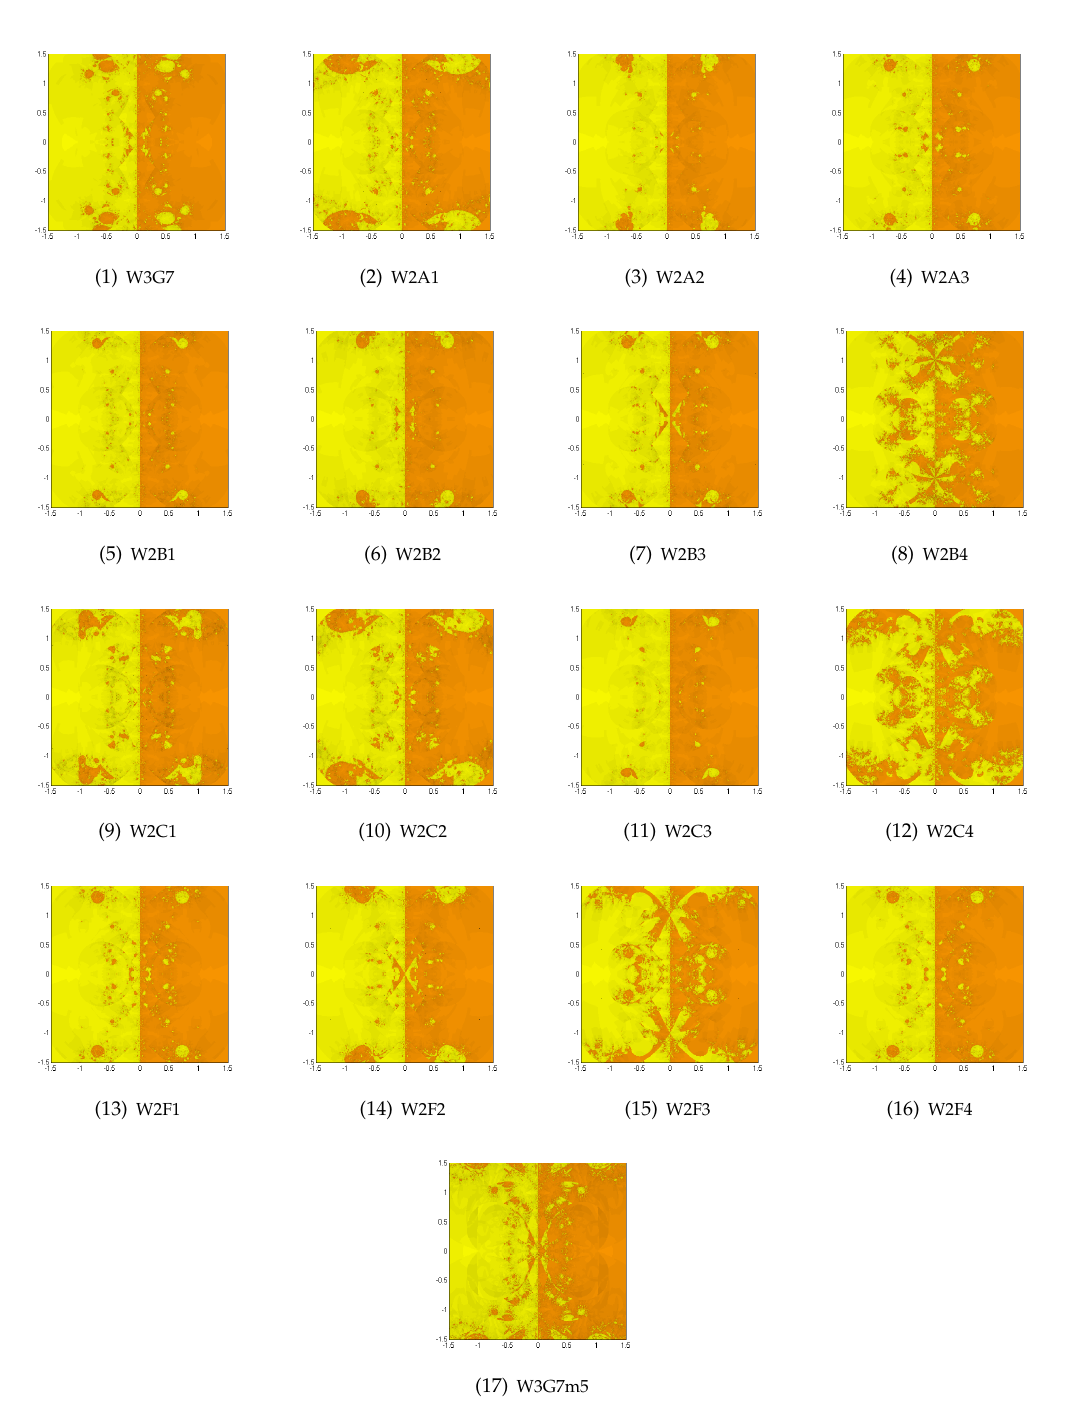
Figure 2. The top row for W3G7 ( left ), W2A1 ( center left ), W2A2 ( center right ) and W2A3 ( right ). The second row for W2B1 ( left ), W2B2 ( center left ), W2B3 ( center right ) and W2B4 ( right ). The third row for W2C1 ( left ), W2C2 ( center left ), W2C3 ( center right ) and W2C4 ( right ). The fourth row for W2F1 ( left ), W2F2 ( center left ), W2F3 ( center right ), and W2F4 ( right ). The bottom row for W3G7m5 ( center ), for the roots of the polynomial equation ( z 2 − 1 ) k , k ∈ { 3,5 }